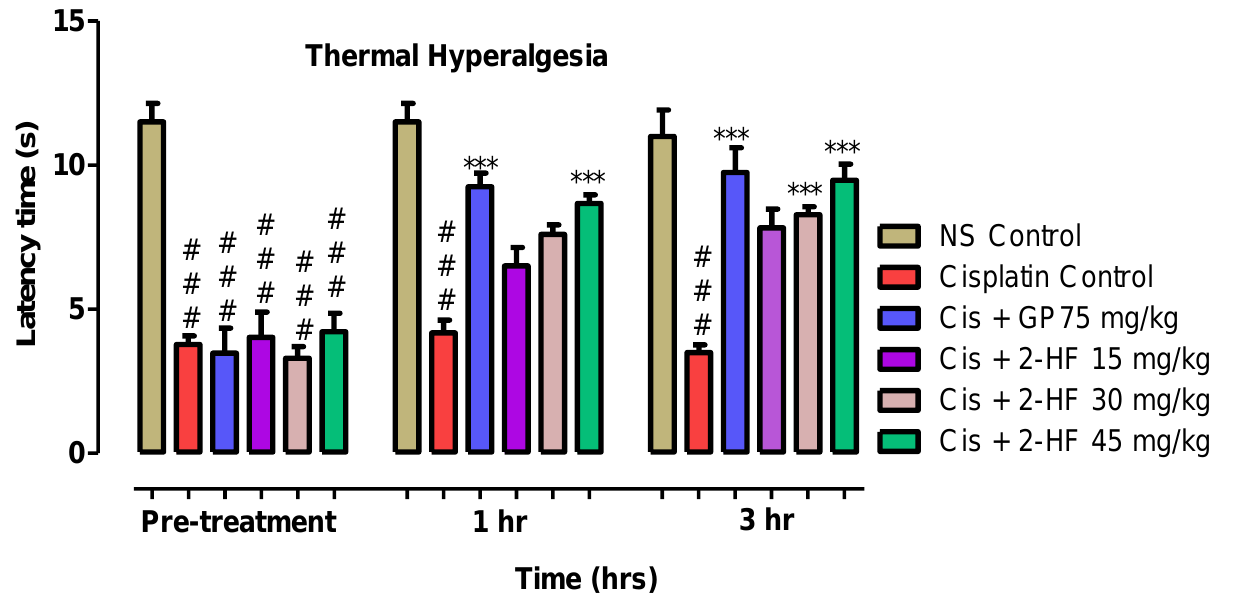
Figure 12. Effect of 2-HF in cisplatin induced neuropathy in hot plate test. *** p < 0.001 for GB + Cis and cis + 2-HF at 45 mg kg − 1 , two-way repeated measures ANOVA followed by Tukey’s post hoc test.